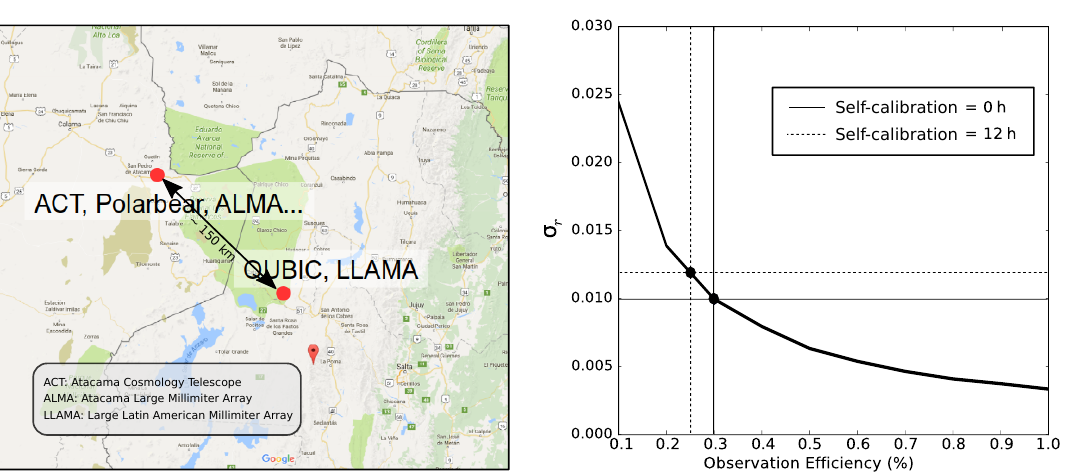
Figure 6. ( Left ) Location of the QUBIC site compared to the Atacama plateau; ( right ) uncertainty in the tensor-to-scalar ratio, r , as a function of the fraction of usable time for two years of operations. The parameter r was computed considering noise-only simulations.